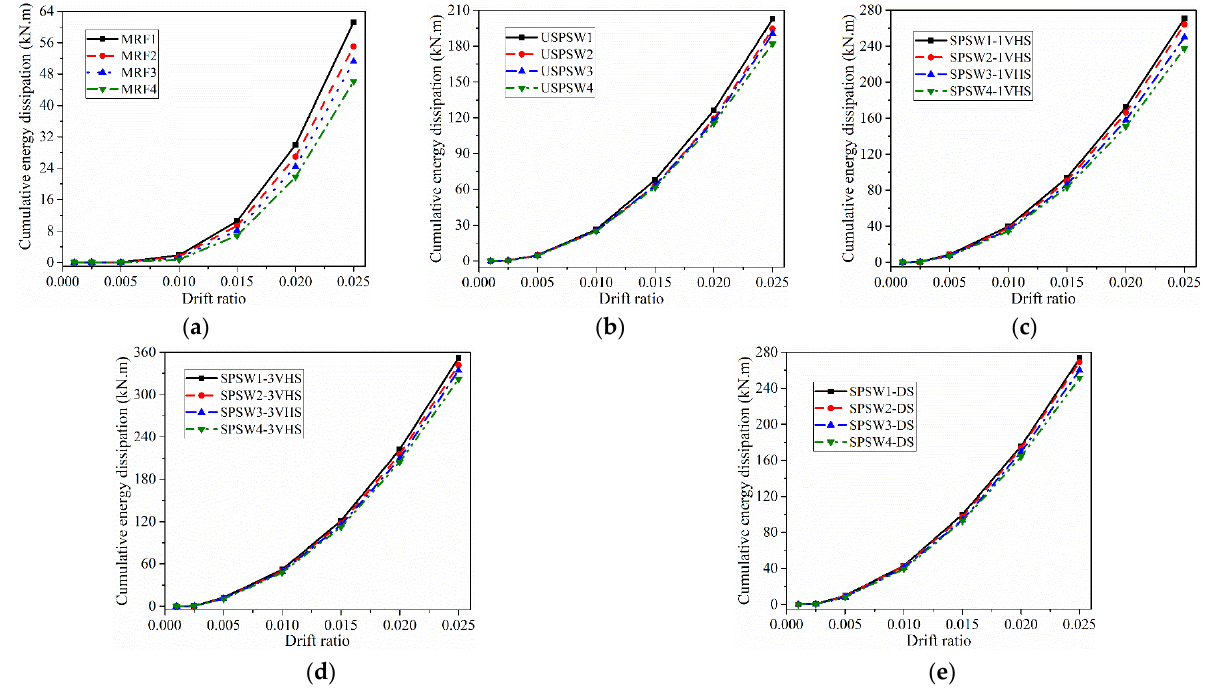
Figure 23. Cumulative energy dissipations of: ( a ) MRF; ( b ) USPSW ; ( c ) SPSW − 1VHS; ( d ) SPSW − 3VHS ; ( e ) SPSW − DS with variable column flexural stiffnesses.